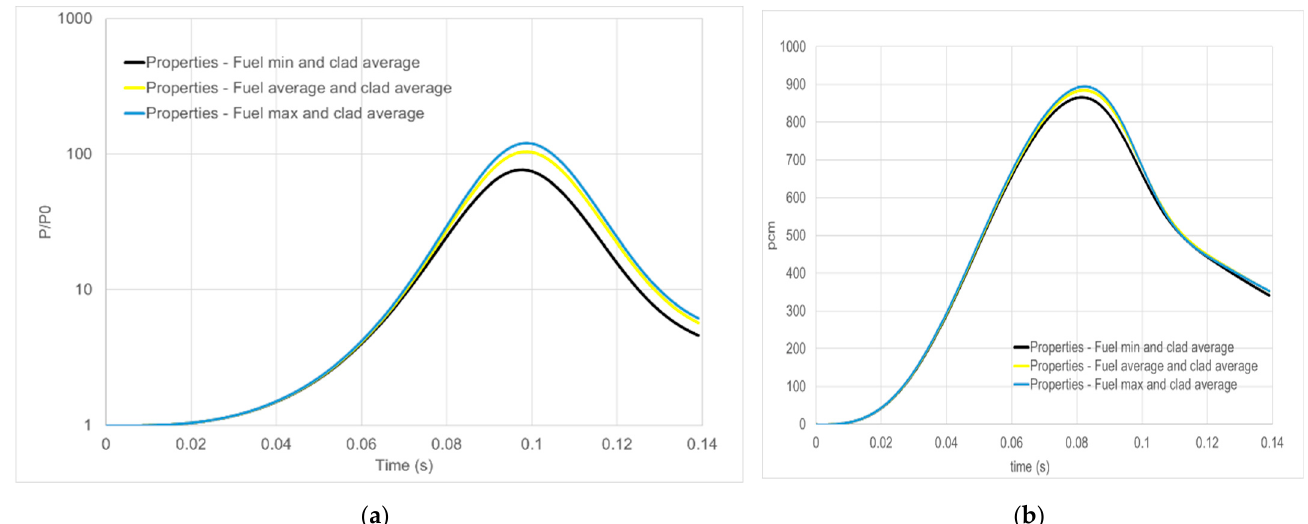
Figure 22. Thermal properties: ( a ) fuel thermal conductivity; ( b ) cladding thermal conductivity; ( c ) fuel thermal capacity; ( d ) cladding thermal capacity [19].